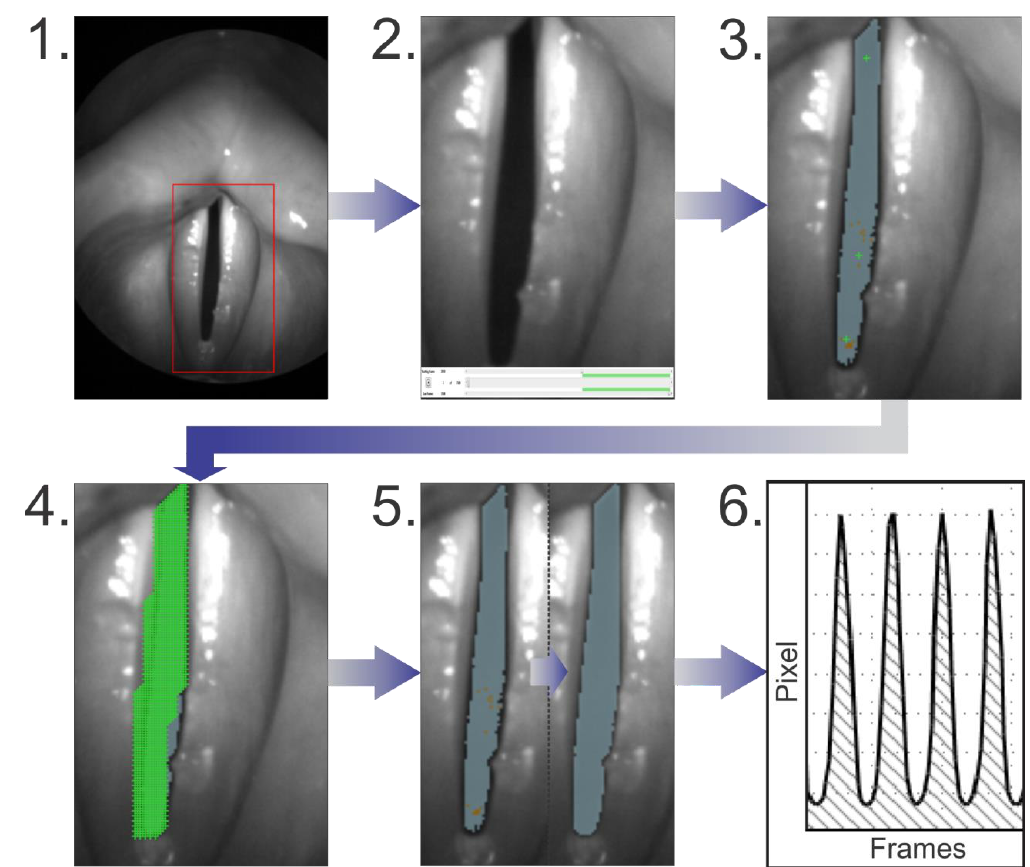
Figure 2. Illustration of the segmentation process: ( 1 ) Selection of the region of interest; ( 2 ) Selection of a time interval with constant phonation; ( 3 ) Rough pre-segmentation; ( 4 ) Applying a seed point grid; ( 5 ) Refinement of the brightness thresholds; ( 6 ) Extraction of the total GAW.